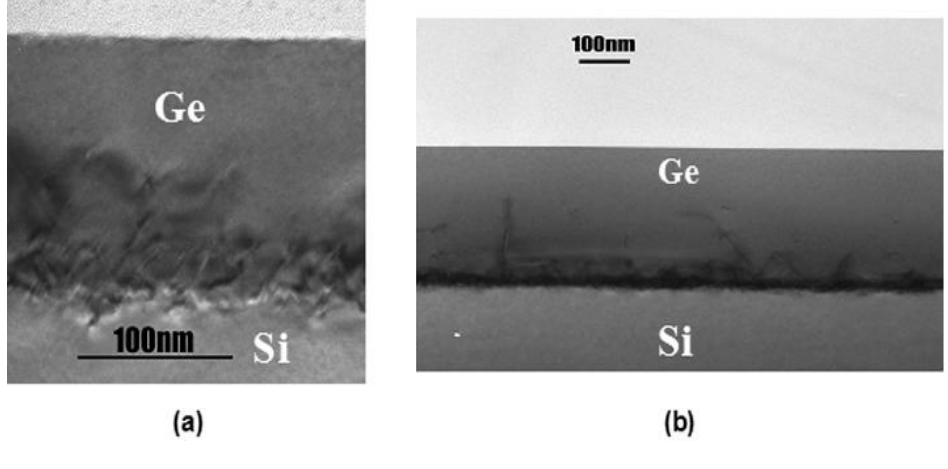
Figure 2. Cross-sectional TEM images of heteroepitaxial-Ge layers on Si; ( a ) 155 nm of Ge grown in single growth cycle with one H anneal step and ( b ) 400 nm of Ge layer grown in two growth cycles with two H annealing cycles (MHAH method), reprinted with permission from [36]. Copyright 2005,